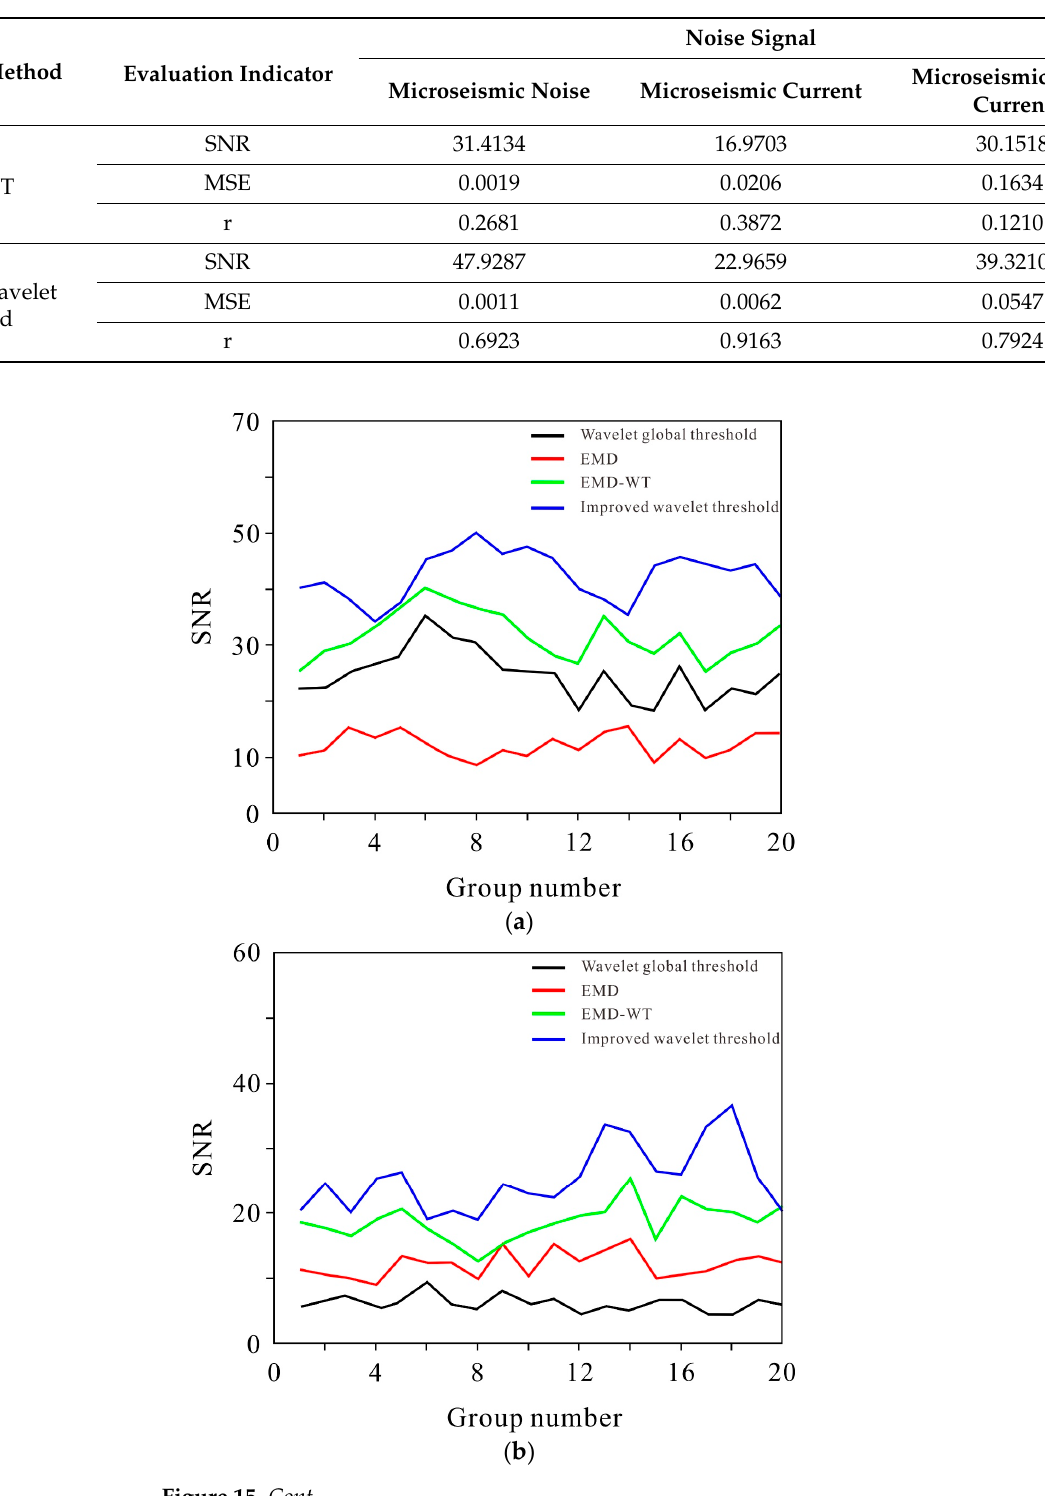
( c ) Figure 15. Comparison of the SNR distributions for different types of microseismic data after de- noising: ( a ) microseismic noise signal, ( b ) microseismic current signal and ( c ) microseismic signal with noise and current.